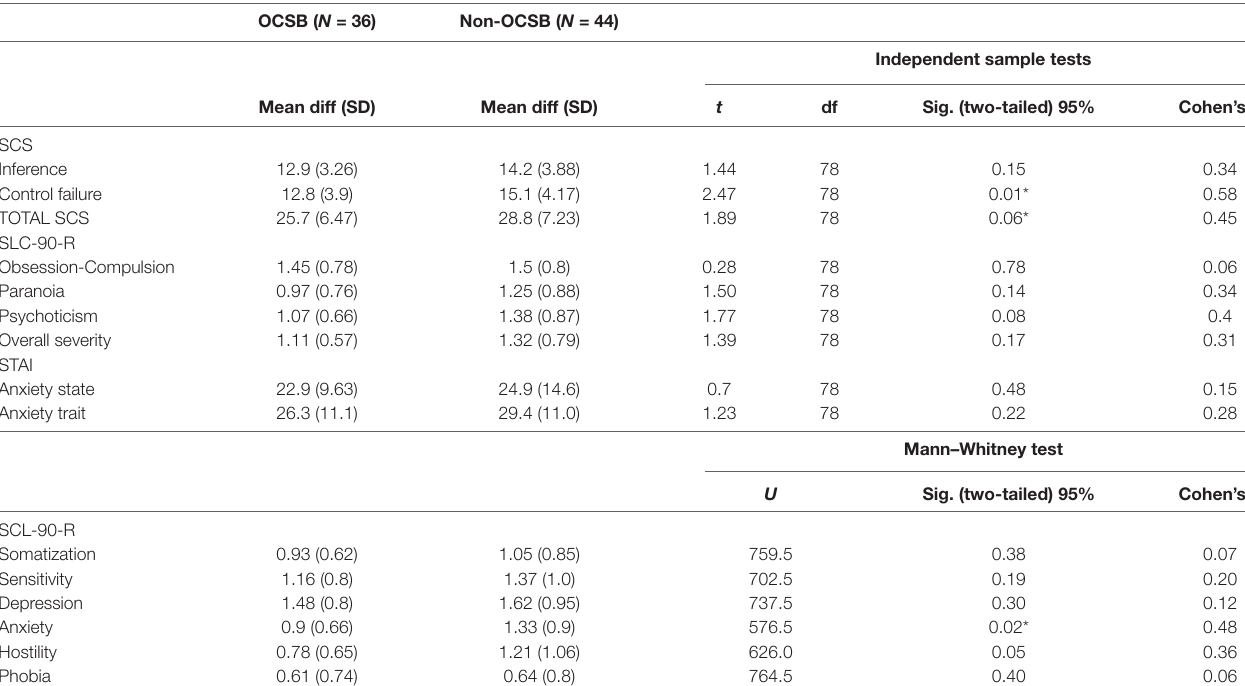
TABLE 5 | Comparison between OCSB and non-OCSB patients of psychopathological